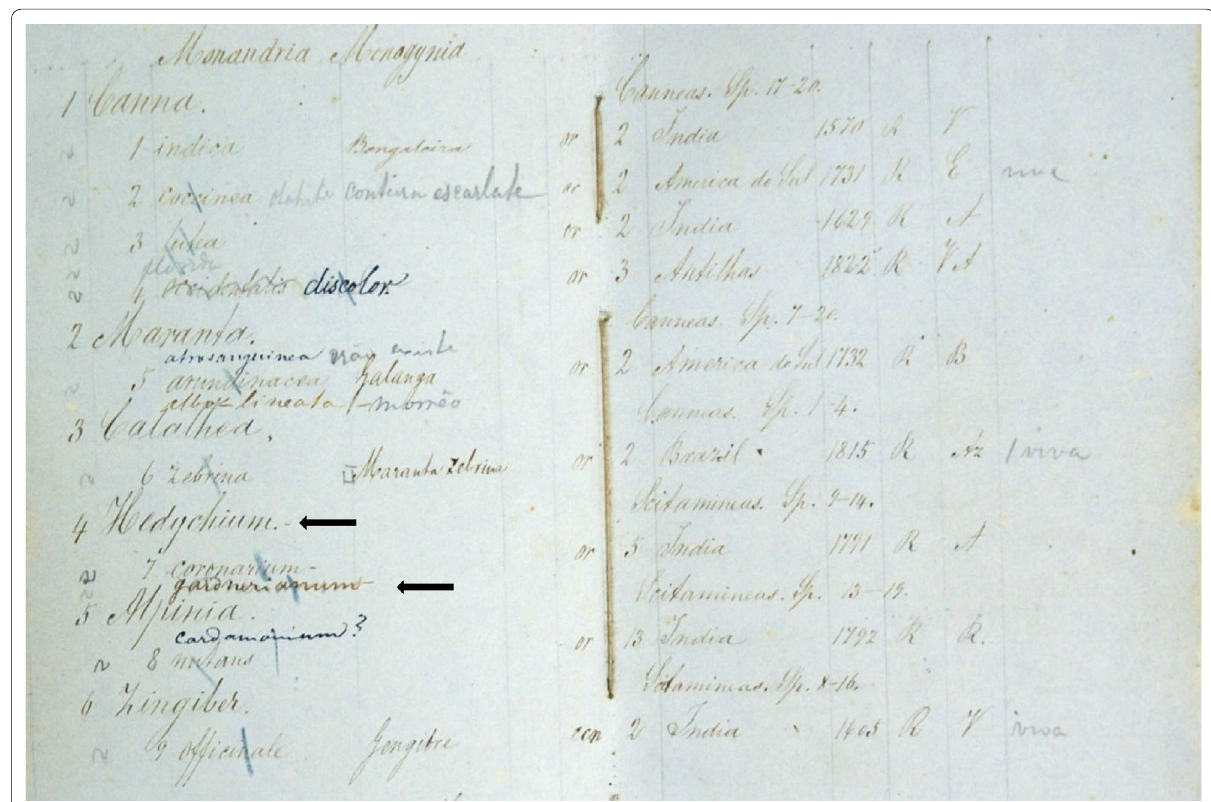
Fig. 6 Manuscript list of the cultivated plants in José do Canto Garden, in the year 1851 (S. Miguel Island, Azores). Hedychium gardnerianum ( ) (Courtesy of Azores University